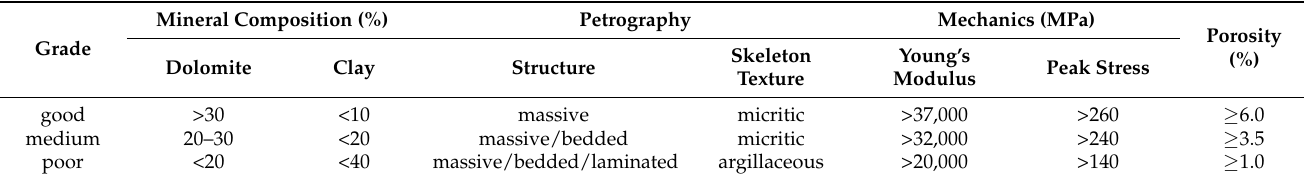
Table 6. Local standard of reservoir brittleness classification.